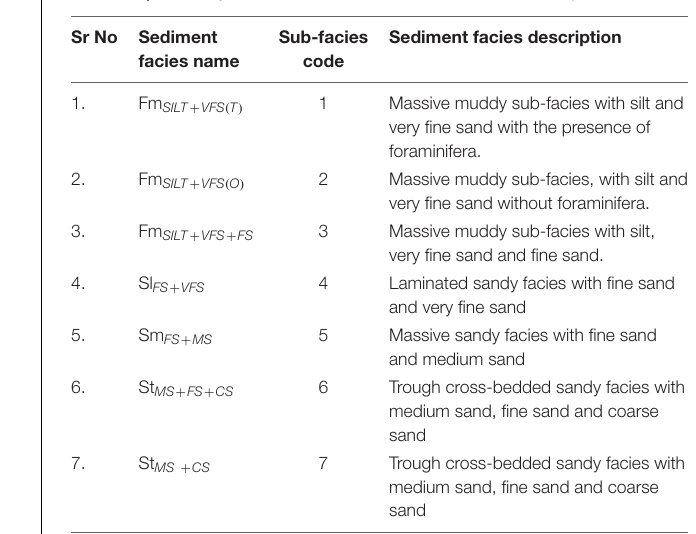
TABLE 3 | Summary of sub-facies notations, code and their